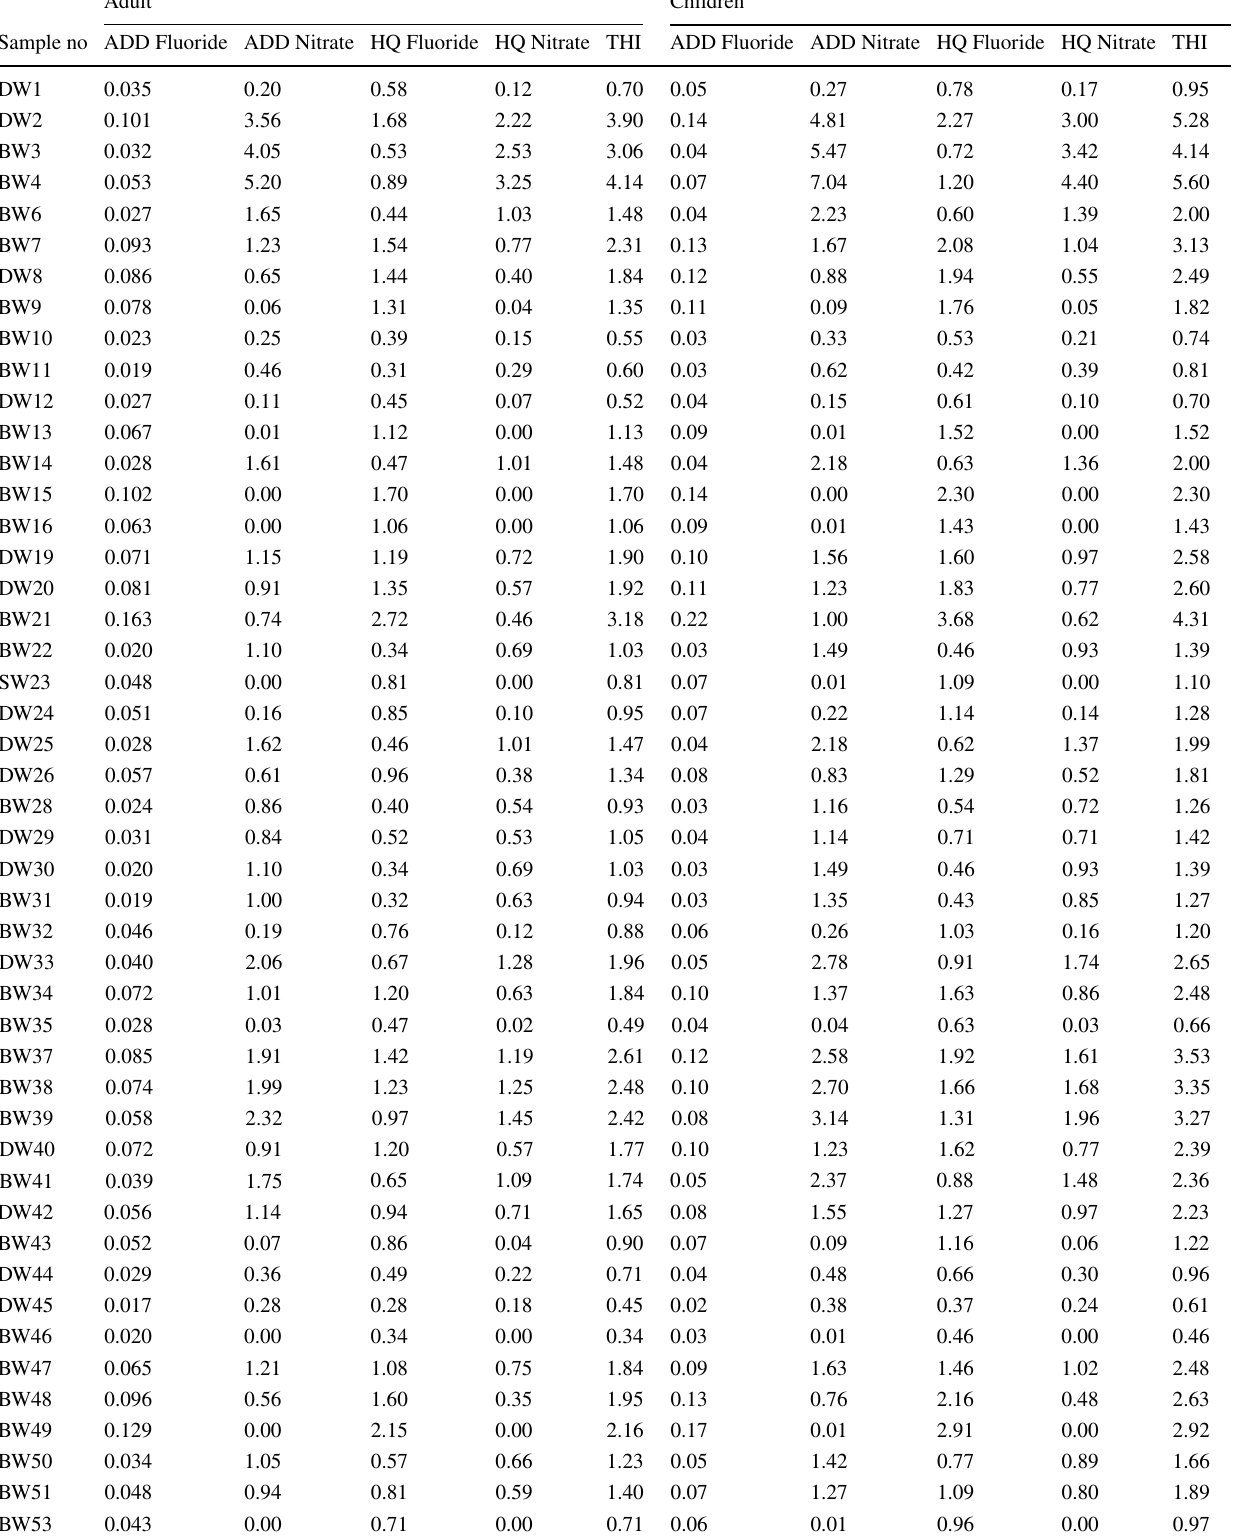
Table 3 Average daily dose (ADD) hazard quotient (HQ) and total hazard index (THI) for adults and children in the study area for pre-monsoon season